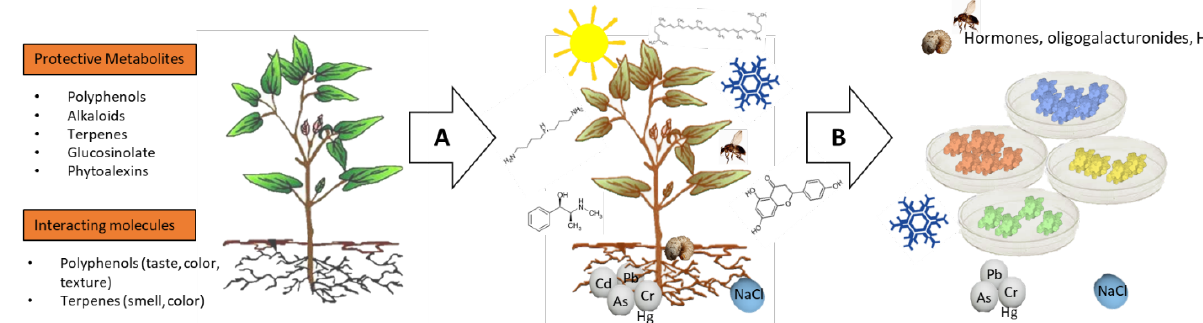
Figure 1. ( A ) Plants produce several bioactive molecules that have a protective or interacting role in the surrounding environment. ( B ) The biosynthesis of these metabolites is boosted during environmental cues, as well as biotic and abiotic stresses. ( C ) The environmental constraints or the plant endogenous signalling molecules, which induce the compound accumulation, can be used as an “elicitor” to boost the production of molecules with industrial interest, including in in vitro culture systems (e.g., undifferentiated cell cultures).